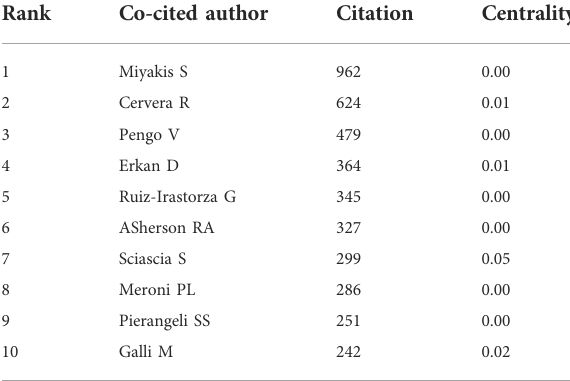
TABLE 4 Top 10 co-cited authors with the most citations involved in